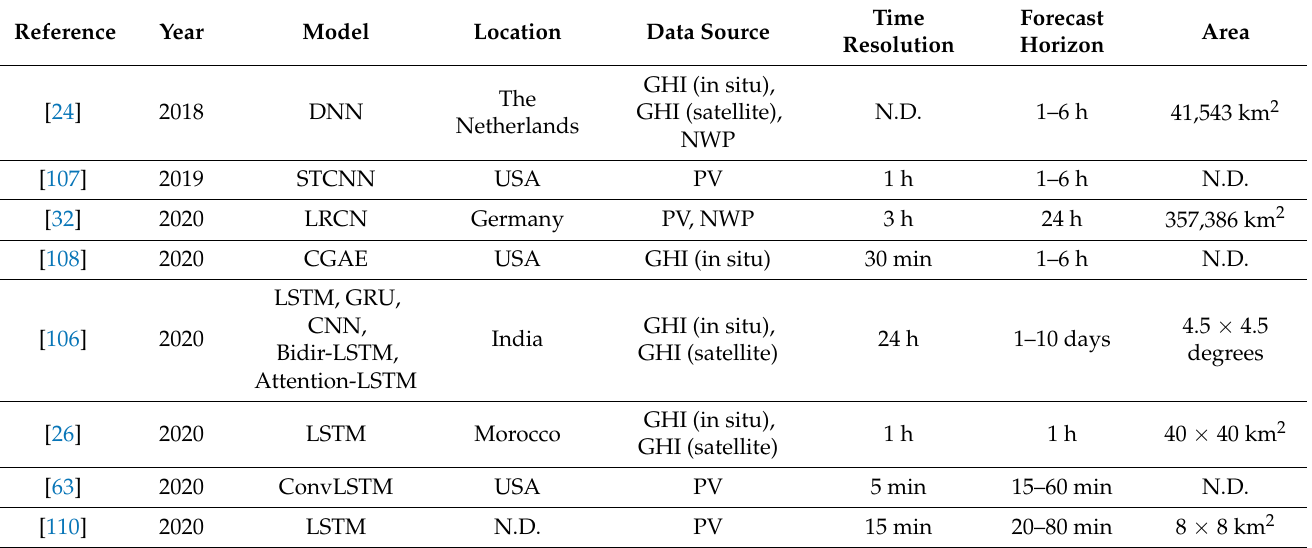
Table 4. Summary of available literature (2018–2021) for the application of deep learning methods regarding spatio-temporal solar forecasting